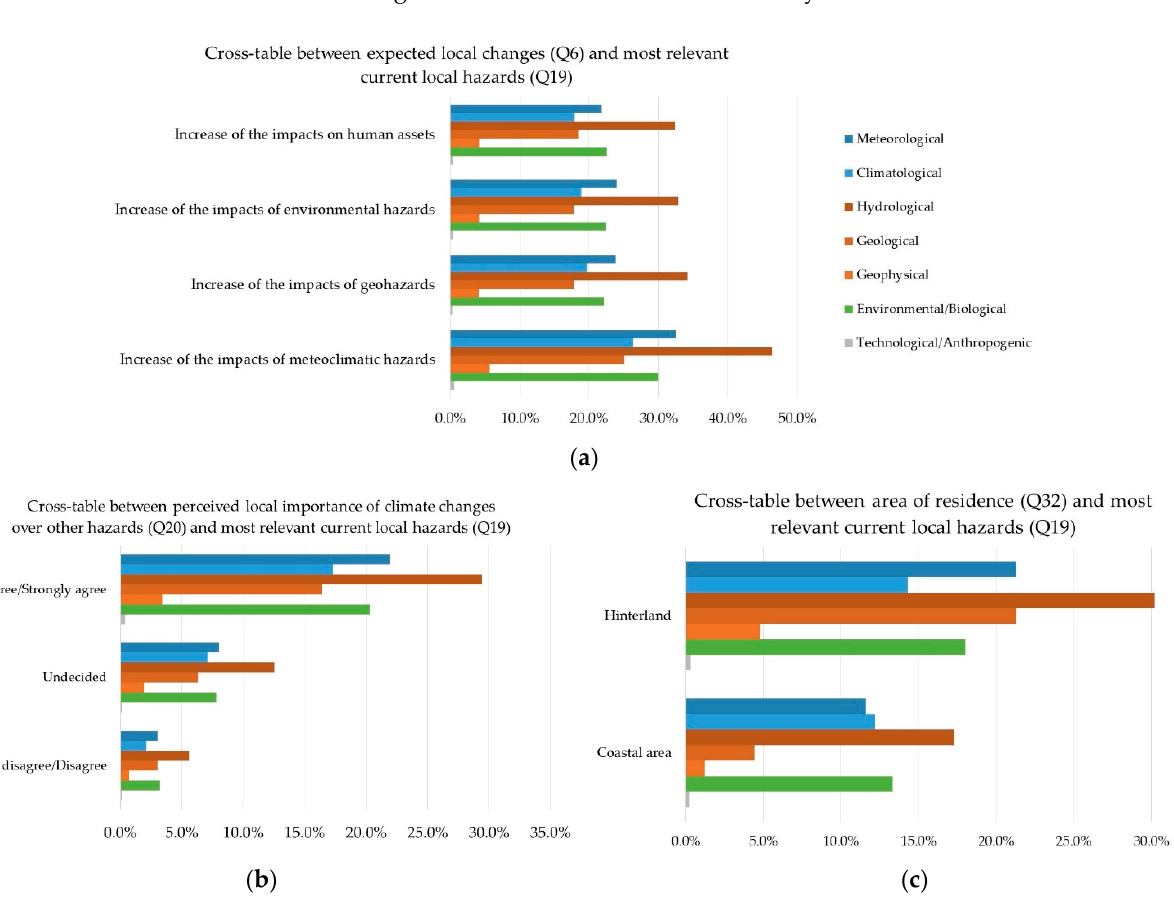
Figure 3 . Graphical representation of the cross tables between the perception of the most relevant current local hazards related to ( a ) the expected local changes (Q6 and Q19), ( b ) the perceived local importance of climate changes over other hazards (Q20 and Q19), and ( c ) the area of residence (Q32 and Q19).